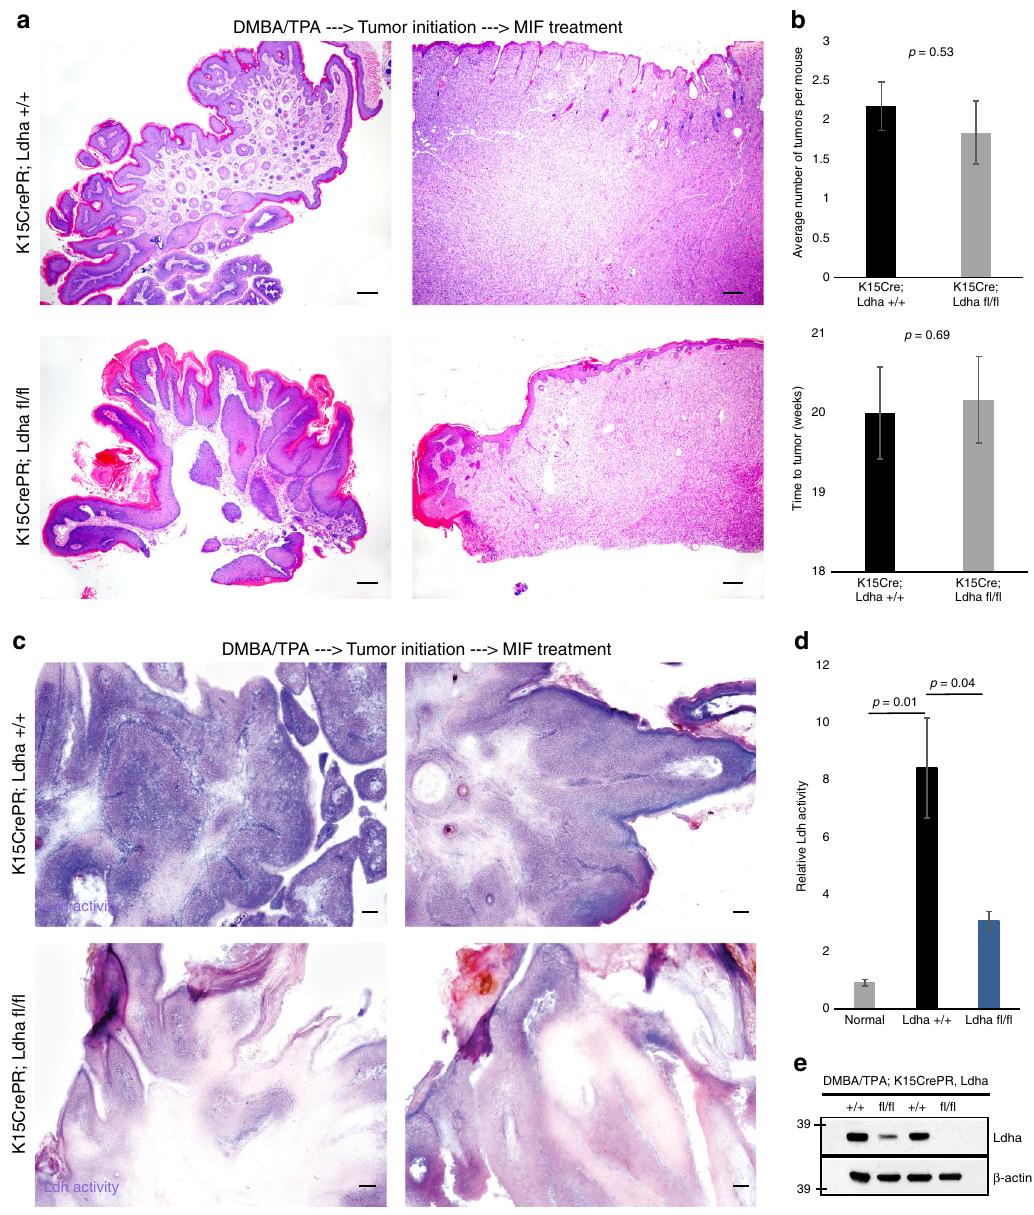
Fig. 5 Deletion of Ldh activity in nascent tumors does not affect tumor progression. a Taking advantage of chemical carcinogenesis coupled with transgenic deletion of Ldha , we allowed tumor initiation to begin and then deleted Ldha by administration of Mifepristone in transgenic animals. Haematoxylin and Eosin stain shows similar histology in wild-type and Lda-null tumors. Scale bars, 200 µ m. b Quanti fi cation of tumor formation and progression failed to uncover an effect of loss of Ldha . Each bar represents the mean where n = 12 mice per genotype. Shown as mean ± SEM. Paired t test was performed, p < 0.05 shown for knockout versus wild-type tumors. c In situ Ldh activity assay con fi rmed that deletion of Ldha after tumorigenesis had begun was effective at abrogating Ldh activity in tumors. Activity is indicated by purple color; pink is a nuclear counterstain. Scale bars, 100 µ m. d A plate reader assay for Ldh activity also showed that the Ldha deletion was effective. Each bar represents the relative ldh activity signal for each genotype type, where n = 6 mice per genotype. Shown as mean ± SEM. Paired t test was performed, p < 0.05 shown for each tumor genotype vs. control skin. e Western blotting for Ldha and a loading control to show the effectiveness of Ldha deletion after tumor